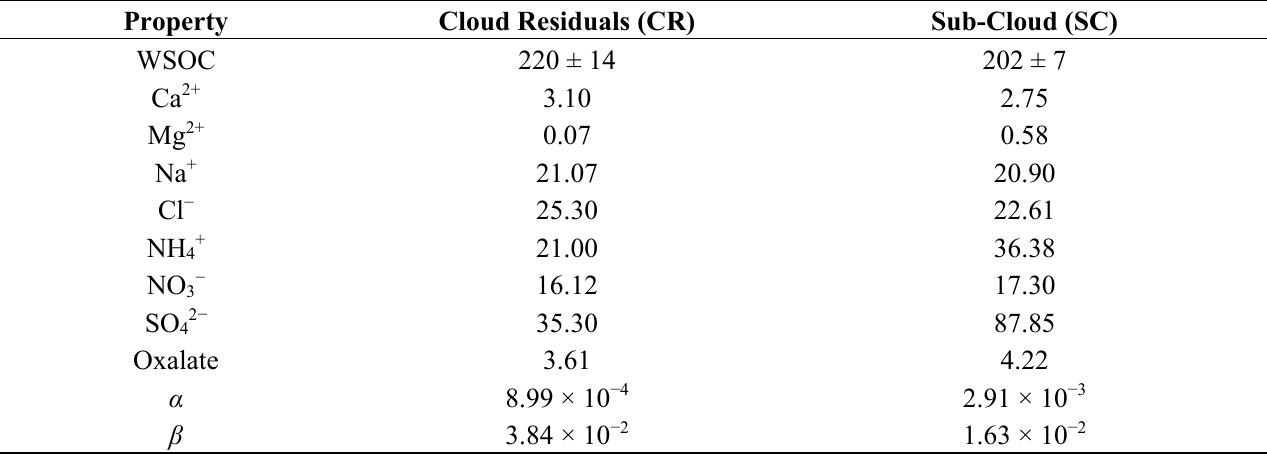
surface tension model * [45] fits for the aerosol samples